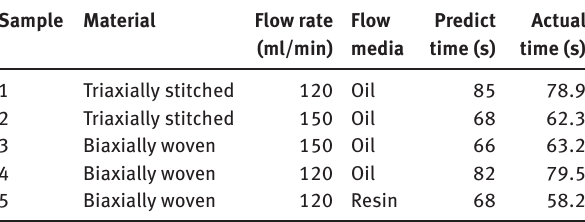
Table 2: Filling times for flow